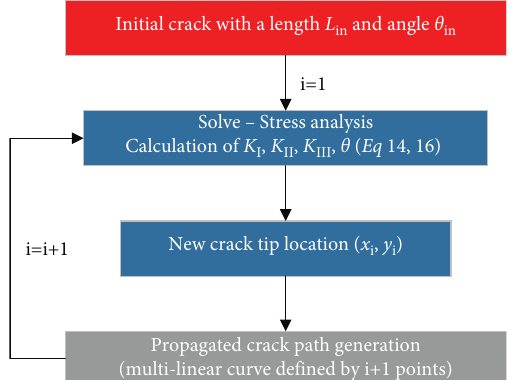
Figure 22: Numerical procedure for the fatigue crack growth simulation.